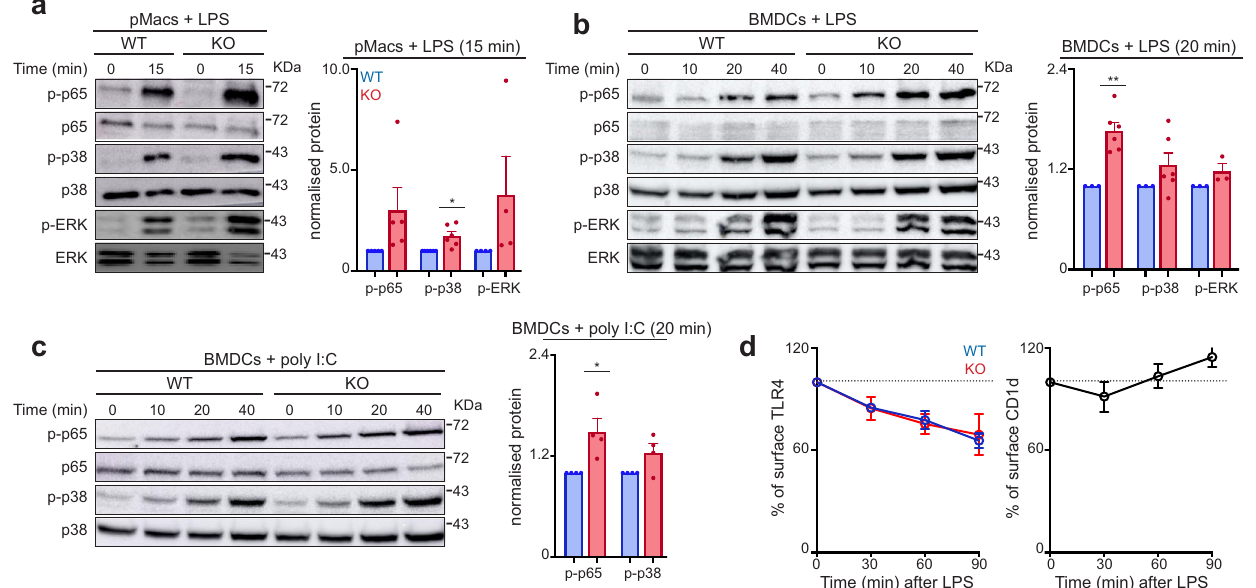
Fig. 2 | Increased TLR signalling in CD1d-KO cells. a Western blot analyses of phosphorylation of p65,p38and ERKin pMacs isolated from WTorCD1d-KOmice stimulated with LPS for 15min (left). Levels of phosphorylated p65 ( n =5), p38 ( n =6) and ERK ( n =4) were quanti fi ed and related to total p65, p38 and ERK respectively (right). Bars represent mean+/ − SEM; * p <0.05; one-sample t -test. b , c Westernblotanalysesofphosphorylationofp65,p38andERKinWTandCD1d- KOBMDCs stimulated with LPS ( b ) or poly I:C ( c ) for the indicated times. Levelsof phosphorylatedp65,p38andERKwerequanti fi edandrelatedtototalp65,p38and